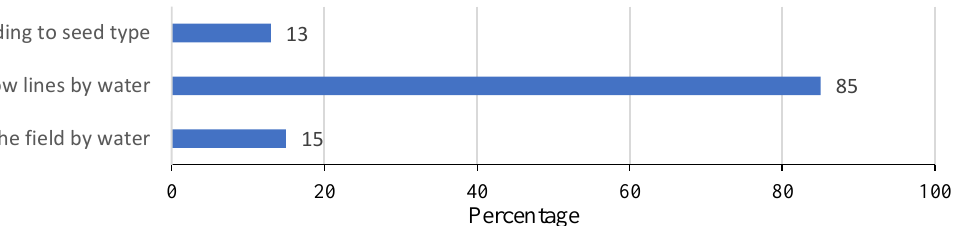
Figure 5. Percentage of ‘Yes’ responses relevant to cotton irrigation questions (It was open-ended question; 42 participants cultivated cotton crops and responded to the cotton-related questions).